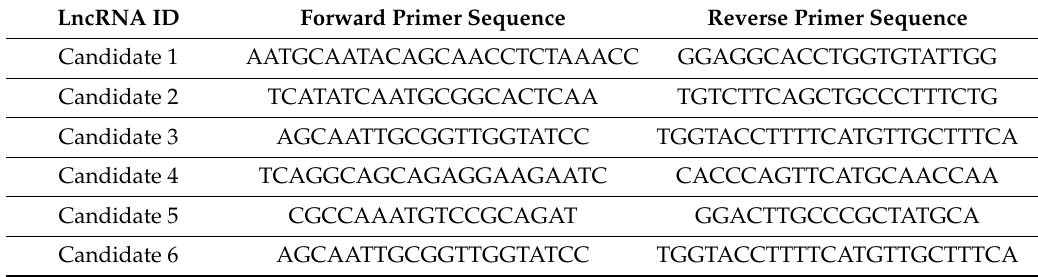
Table 2. The following primers were used to assess the relative expression of three selected lncRNAs which presented a higher degree of conservation and predicted second structure